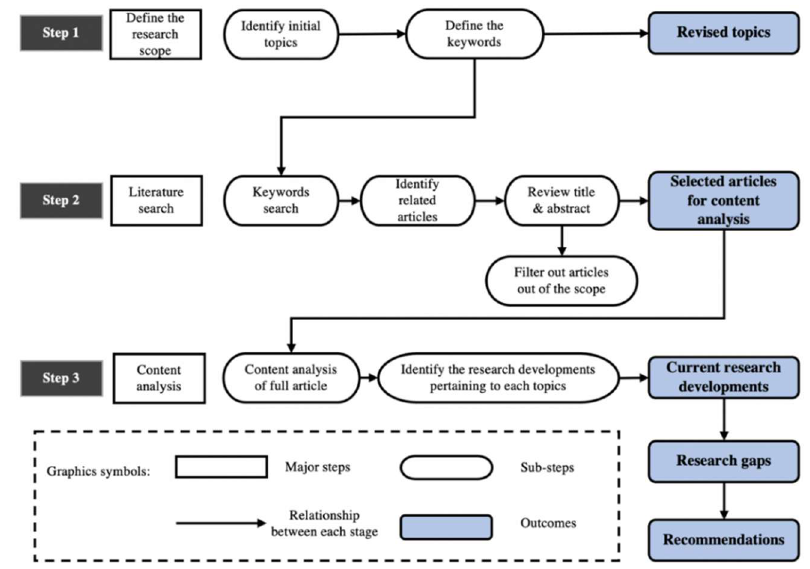
Figure 3. Research methods and procedure of this